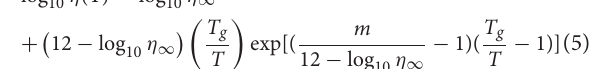
FIGURE 10 | Observed variation of (A) the Non-reversing heat flow, 1 H nr (x) in present glasses ( •) compared to previous work of Tao and Boolchand ( N , •), (B) the specific change 1 C p (x), and (C) the fragility index, m, in the especially homogenized ternary Ge x As x Se 100 − 2x glasses in the present work. Also projected is the variation of melt viscosity, η at 950 ◦ C expected using the measured m and the MYEGA